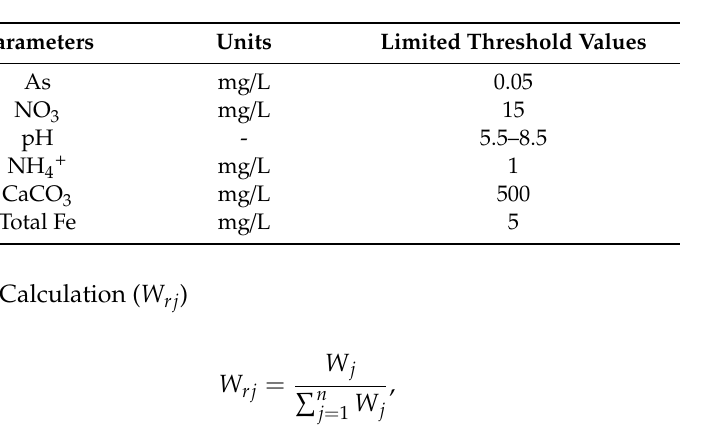
Groundwater quality parameters, units, and limited threshold values based on the Vietnamese